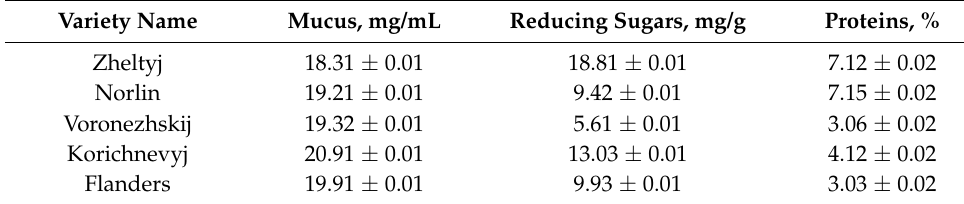
Table 3. Results obtained from the study of oil flax